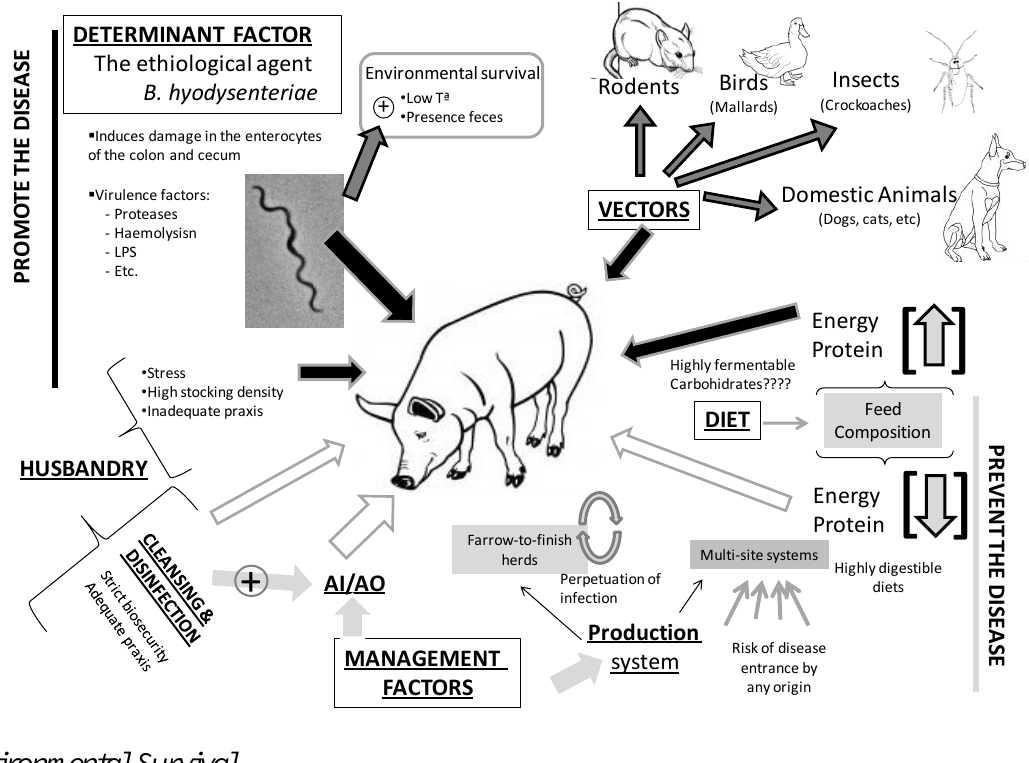
Figure 1. Factors influencing the establishment and transmission of Swine Dysentery (SD). The determinant factor of the disease is the pathogen Brachyspira hyodisenteriae whose persistence in the environment is enhanced by low temperatures and the presence of faeces. Factors which promote the transmission, establishment and persistence of the disease are the presence of vectors, diets with high energy and proteins, and bad husbandry practices; the role of highly fermentable diets is unclear. In contrast, all-in/all-out (AI/AO) management together with cleaning and disinfection, strict biosecurity and highly digestible diets are preventive factors to the establishment of SD. Finally, the production system is a decisive factor to a great extent in the control and prevention of the disease. Farrow-to-finish herds have lower risk of SD entrance but in contrast the persistence of the pathogen is higher than in multi-site production